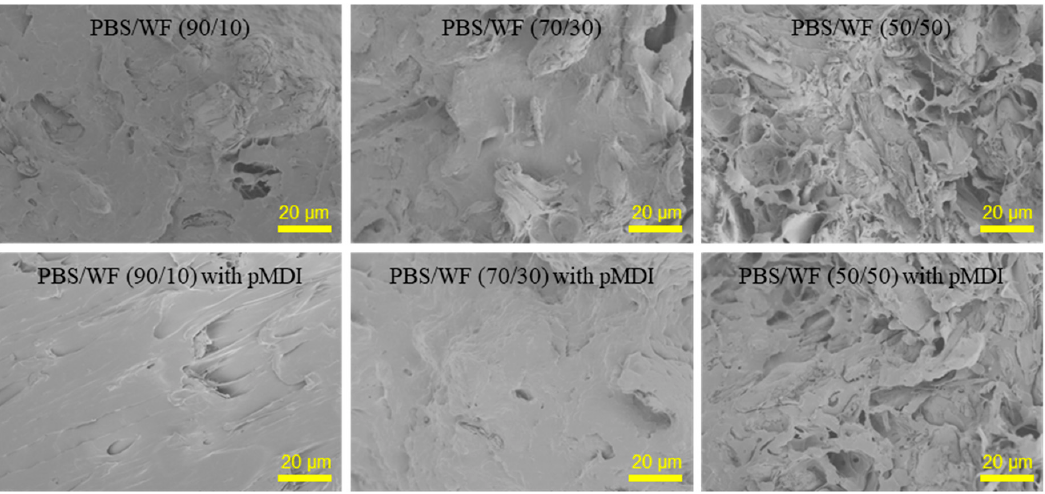
Figure 2. SEM micrographs of the fractured surface of poly(butylene succinate) (PBS)/WF composites with and without polymeric diphenylmethane diisocyante (pMDI) (2 phr).